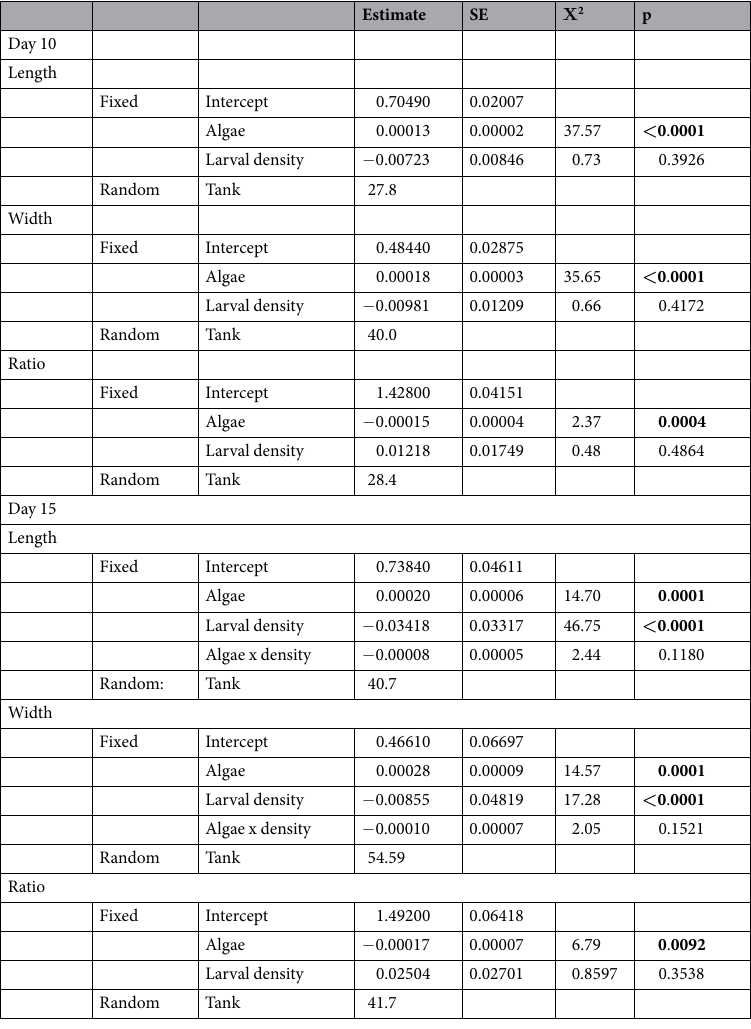
Table 3. Results of linear mixed effects models testing the effect of algae cell concentrations (Algae) and density of larvae (larval density) on the length, width and length to width ratio (ratio) of Acanthaster cf . solaris larvae 10 and 15 days post fertilisation. Significance levels were tested by deviance tests ( Χ 2 and p values). Interactions with p > 0.25 in initial model fits were removed from final models. Tank was included as random factor in the models and the percentage variance (%) explained by this factor given. The variance explained by the total model was 40 (length), 53 (width) and 33% (ratio) at day 10; and 62 (length), 67 (width) and 45% (ratio) at day